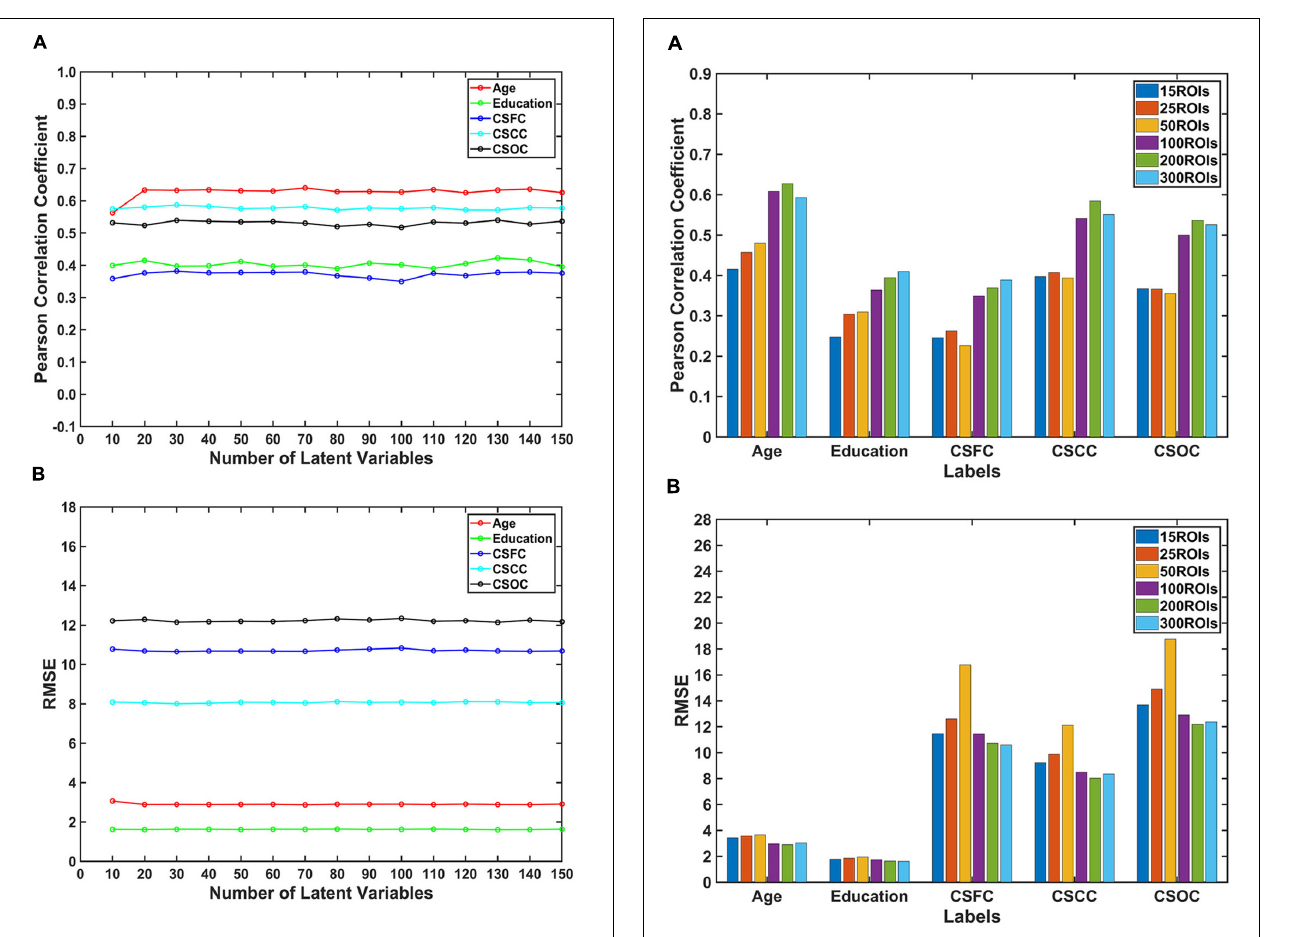
FIGURE 5 | Estimations based on different ROI definition strategies. The reported values were (A) Pearson correlation coefficient and (B) RMSE. The results indicated that estimations based on 100, 200, and 300 ROIs were better than those based on 15, 25, and 50